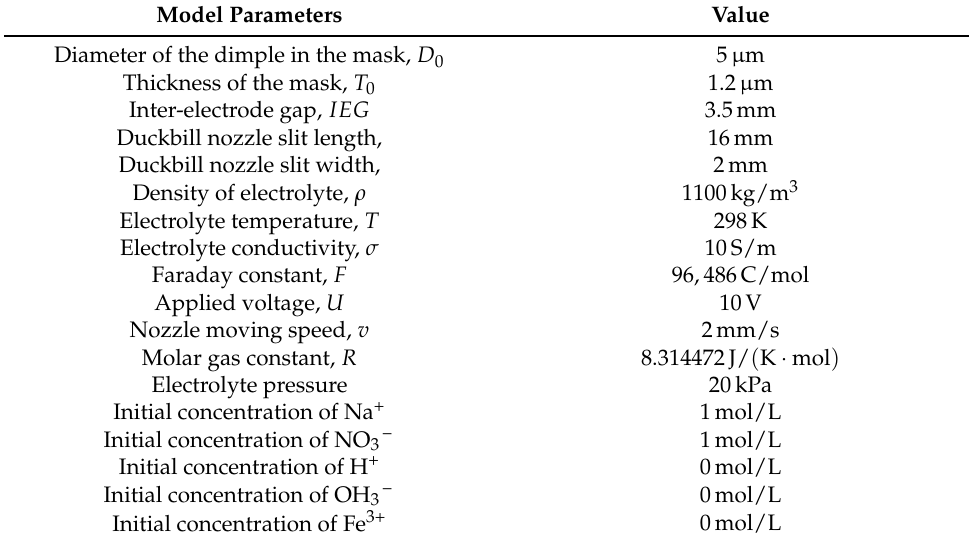
Table 1. The parameters and initial conditions for the